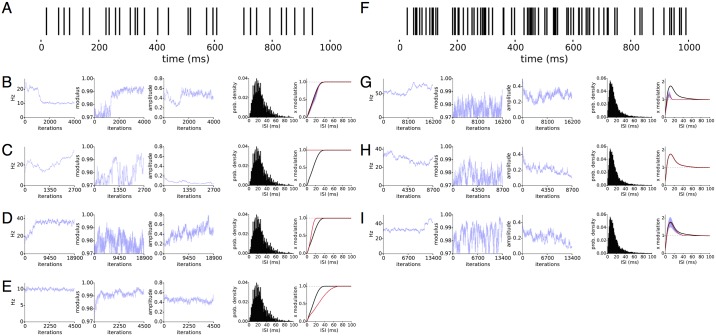
Interaction of spike history and latent state.Two inhomogeneous, history dependent spike trains, with first spike train A) generated with stochastic oscillational modulation at 10Hz and OCV at 0.18, and spiking at 40Hz, and the second spike train F) without modulation, spiking at 60Hz. Gibbs samples from 4 (3) separate LOST for first (second) spike train in B-E (G-I). In B-E and G-I, we show the 3 representative sampled quantities, frequency and modulus of the slowest root and the amplitude of the inferred latent state on the left, and the ISI distribution and spike history term on the right. The ground truth, sampled mean and 5-95% intervals of the sampled spike history term plotted in black, red and cyan, respectively. The differences between the different LOST runs is in how spike history knots were chosen, or if a fixed spike history function was used. For the first spike train A, B uses the standard knot choices, C uses a constant history set to 0 and D, a fixed spike history set to a time-compressed ground-truth history. For the second spike train, G uses the standard knot choice, H the ground truth and I the standard knots moved farther out in time. For the first spike train, misspecification of the history may lead to a false inference of a flat latent state, a latent state with high uncertainty in its parameters or the correct latent state. For the second spike train, a misspecified history can lead to a latent state with significant amplitude but with uncertain parameters, making the inference inconclusive.